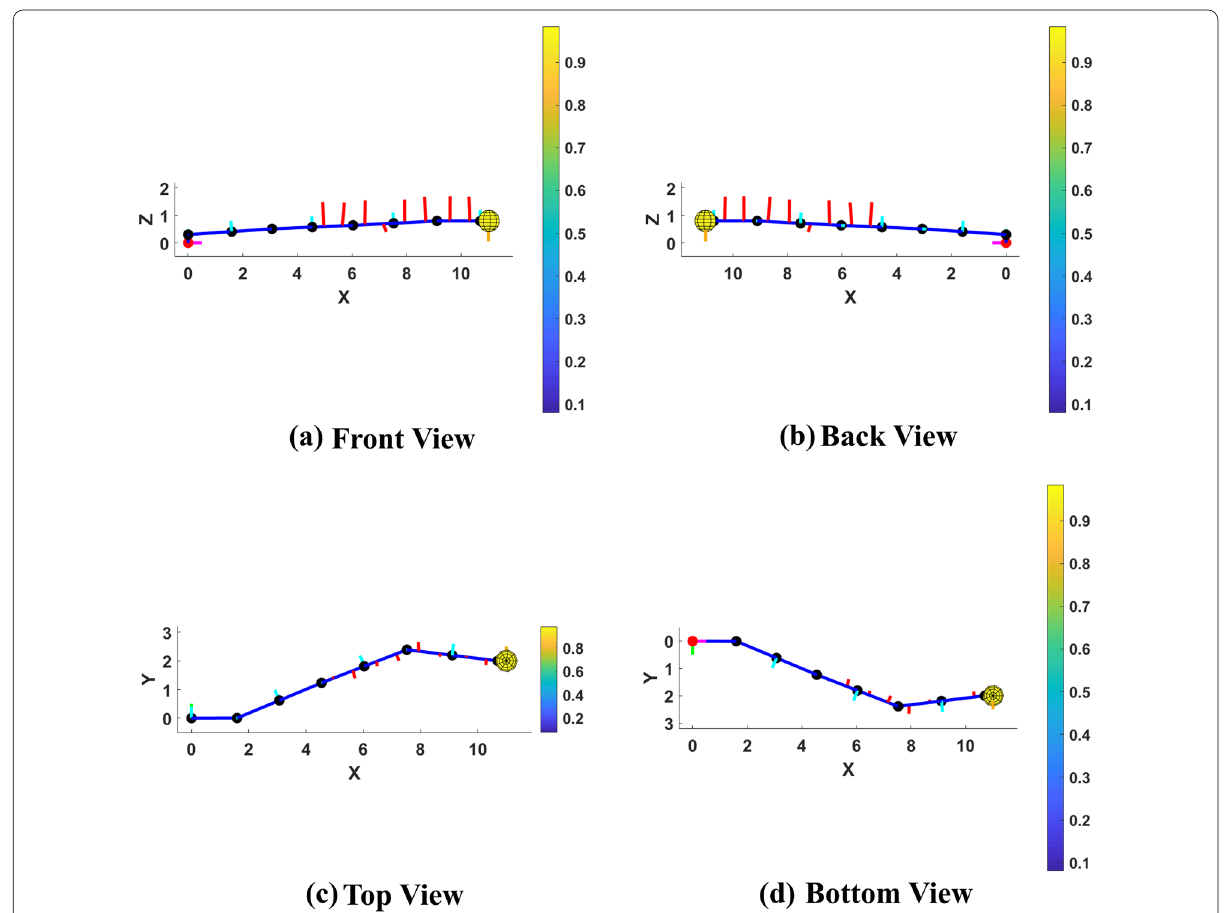
Fig. 7 The front, back, top, and bottom views of the AOWS-based flying watch allocation, end effector reaction force, and the corresponding average thrust drivability surface in the static object holding mission. a Front view. b Back view. c Top view. d bottom